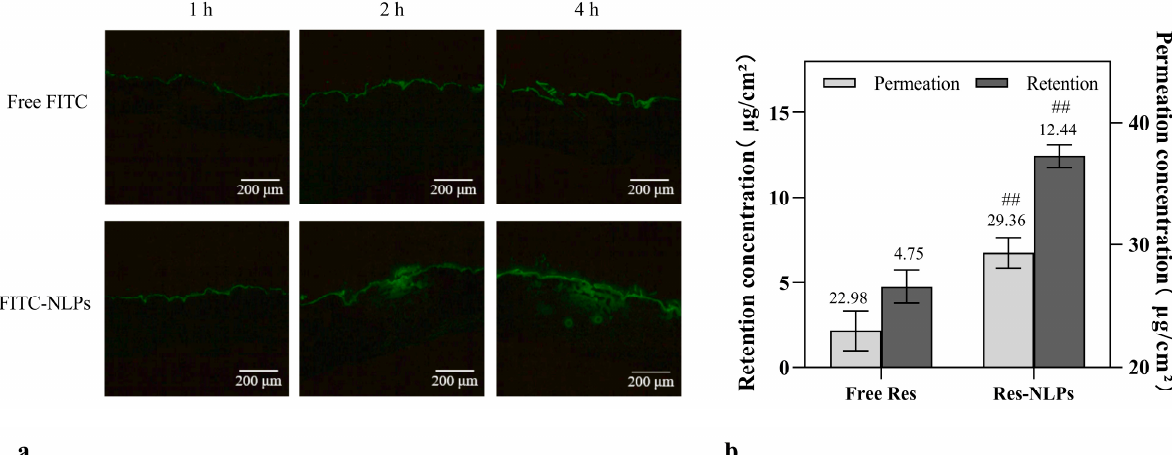
Figure 2. ( a ) Fluorescence microscope images showing in vivo transdermal delivery process. The porcine skin was treated with 10 µ g/mL free FITC or FITC-loaded NLPs with equal FITC concentra- tion for up to 4 h, Scale bar: 200 µ m. ( b ) Cumulative percutaneous permeation and retention of Res after 24 h transdermal delivery. Mean ± SD ( n = 3). ## p < 0.01, compared with the free Res group.